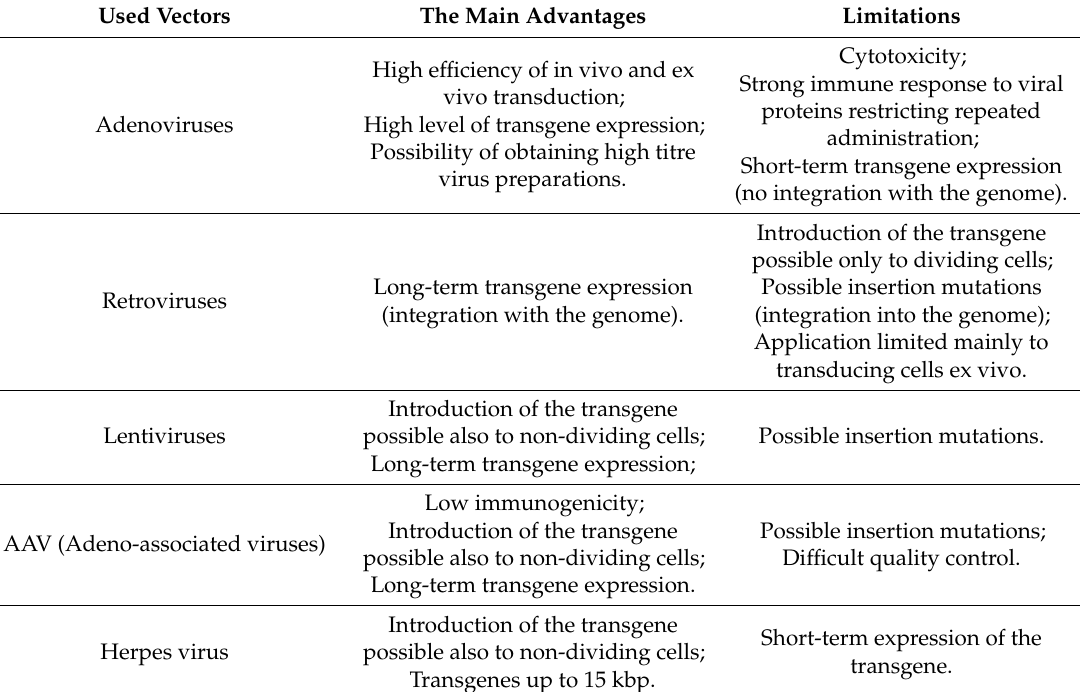
Table 1. Advantages and limitations of the use of viral vectors in gene